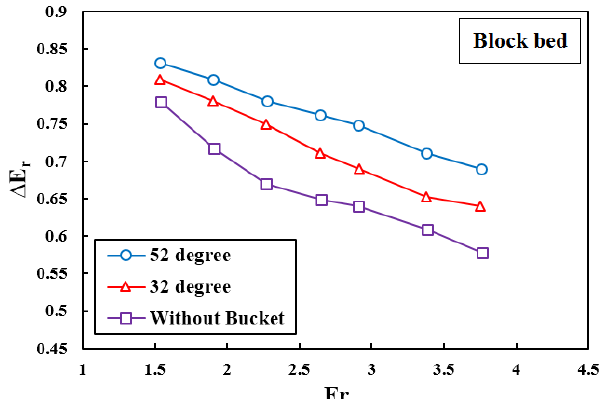
Figure 8. Di ff erence in relative energy dissipation versus Froude number in block bed with di ff erent Figure 8. Difference in relative energy dissipation versus Froude number in block bed with different take-o ff take-off angles.